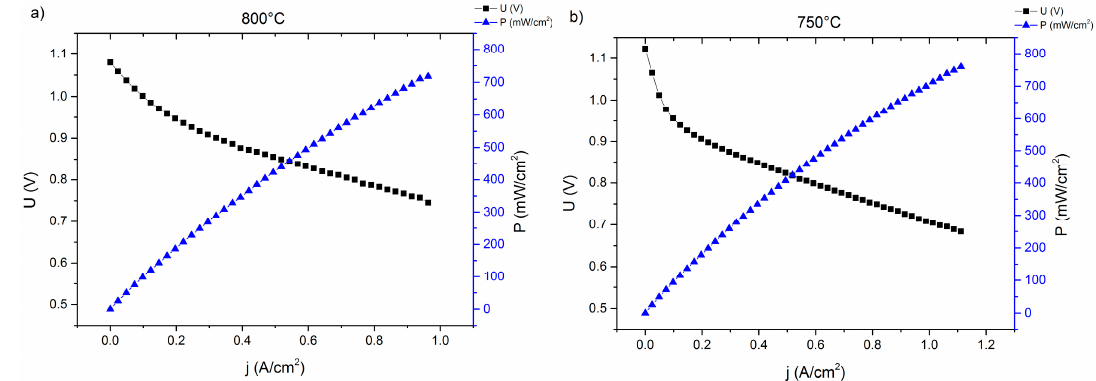
Figure 5. I-V- and I-P-curves of cell 1 during operation in a stationary stack after joining at 800 °C ( a ) and 750 °C ( b ).